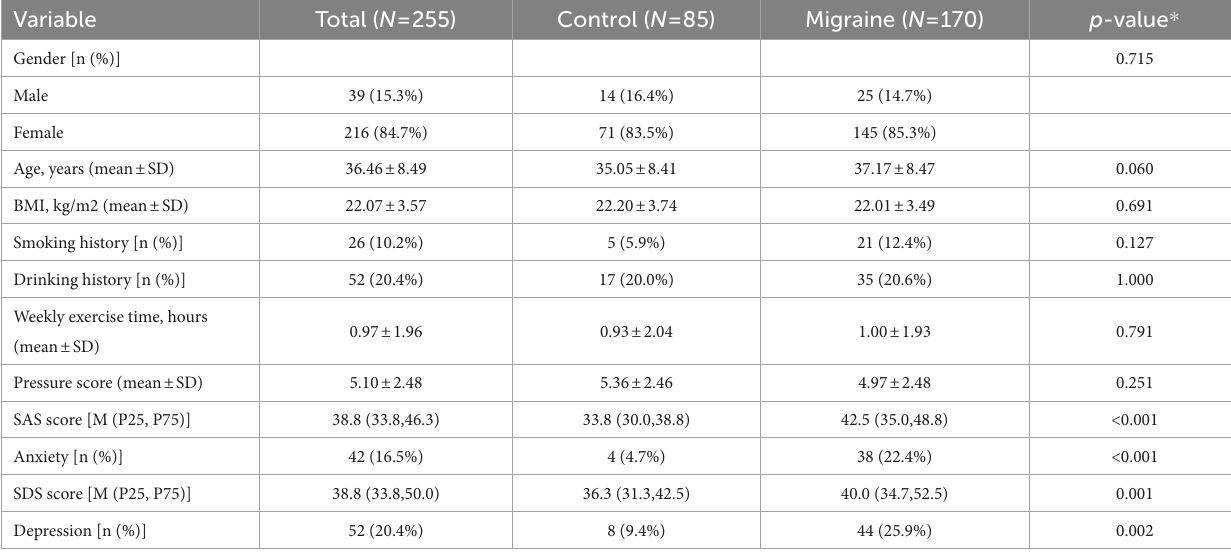
TABLE 1 Baseline characteristics of migraine and control groups.